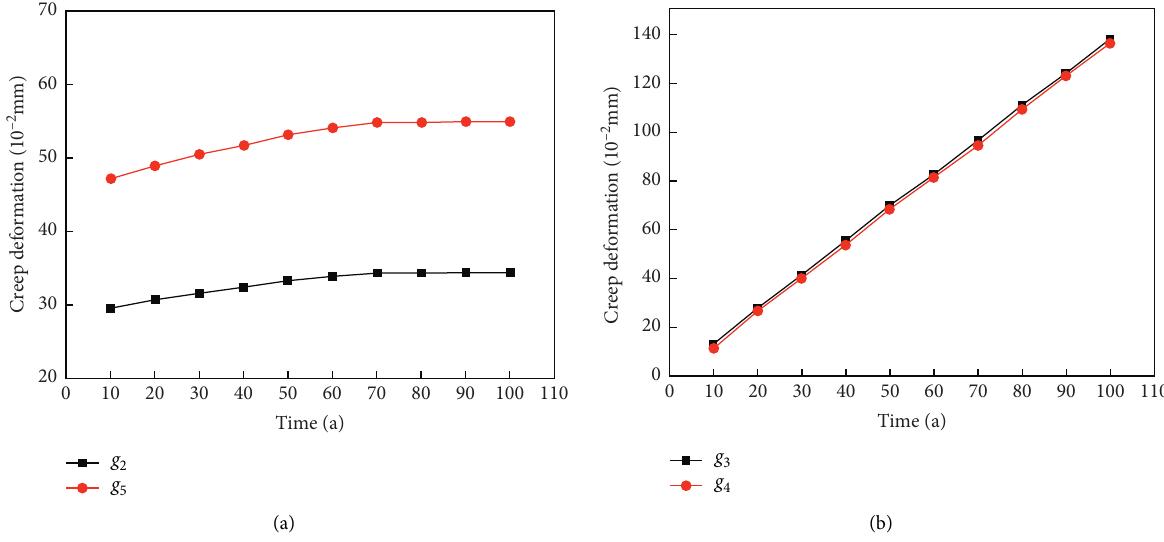
Figure 25: Long-term creep patterns of (a) surrounding rock and (b) real working